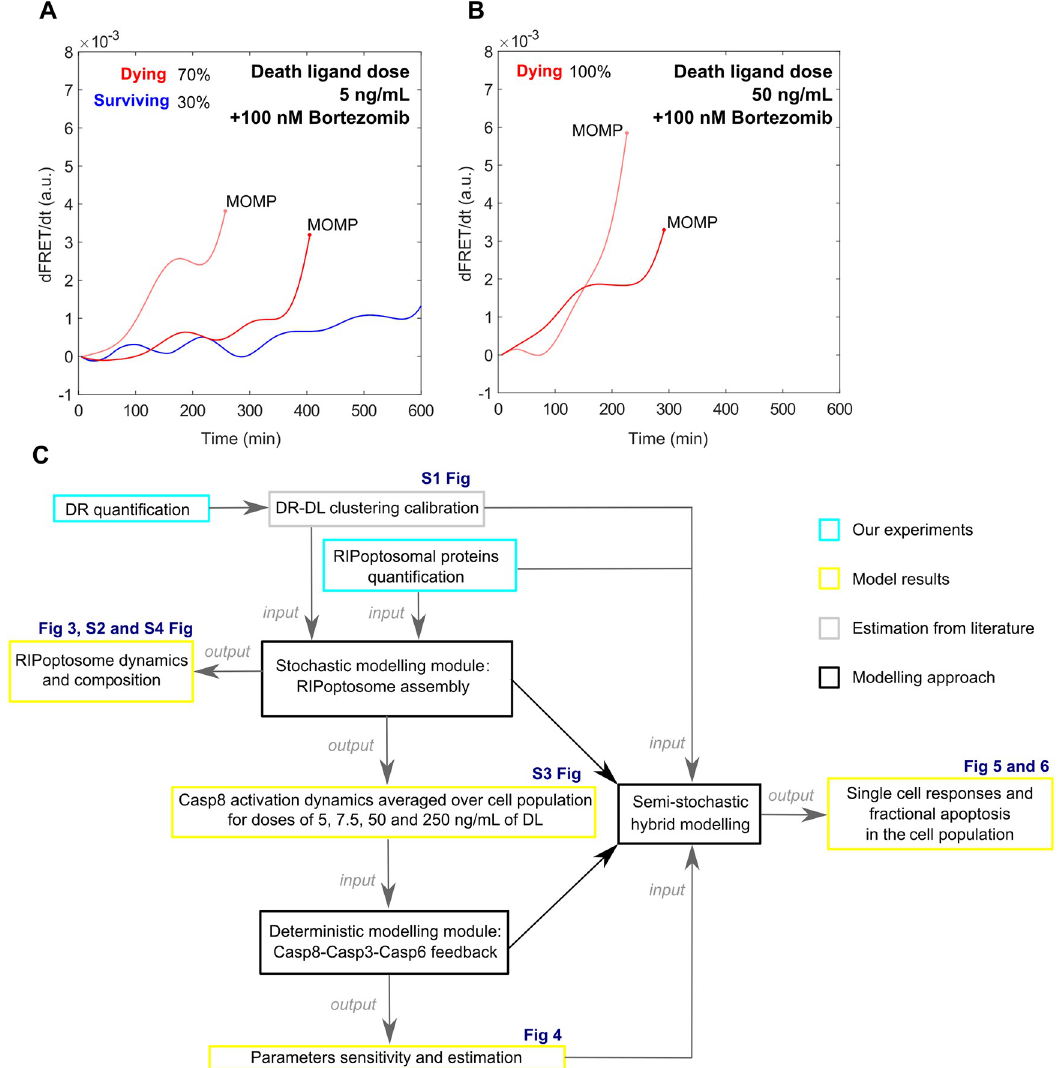
Fig 1. New modelling approach developed in this study to explain vulnerable dynamics of Casp8 activation and fractional cell death upon DR stimulation. (A, B) Casp8 activation dynamics tracked by the FRET reporter cleavage in Hela cells upon treatment with low and high doses of the DR ligand (experimental data from Roux et al ., 2015)[2] as evidence for stochastic fluctuation dynamics and final switch like transition of the Casp8 activity which is the main cause of the fractional cell death. (A) Single cell Casp8 activation upon 5 ng/mL rhTRAIL treatment with 100 nM Bortezomib. Fluctuating ramp in Casp8 activation which leads to activity acceleration and MOMP within first 10 hours (in red) and fluctuating ramp which fails to trigger MOMP (in blue) causing survival of 30% cell population (experimental data from Roux et al ., 2015) [2]. (B) 100% cell death over population induced by 50 ng/ mL rhTRAIL with 100 nM Bortezomib treatment triggered by high acceleration rate of Casp8 activity (in red). (C) Schematic diagram representing the methodological design of this